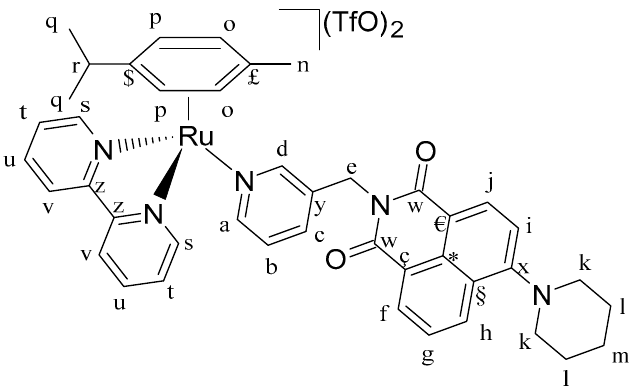
Figure 17 Structure of complex C3. Figure 17. Structure of complex [( η 6-p-cym)Ru(N,N (cid:48) -bpy)(L4)](SO3CF3)2 (C3)